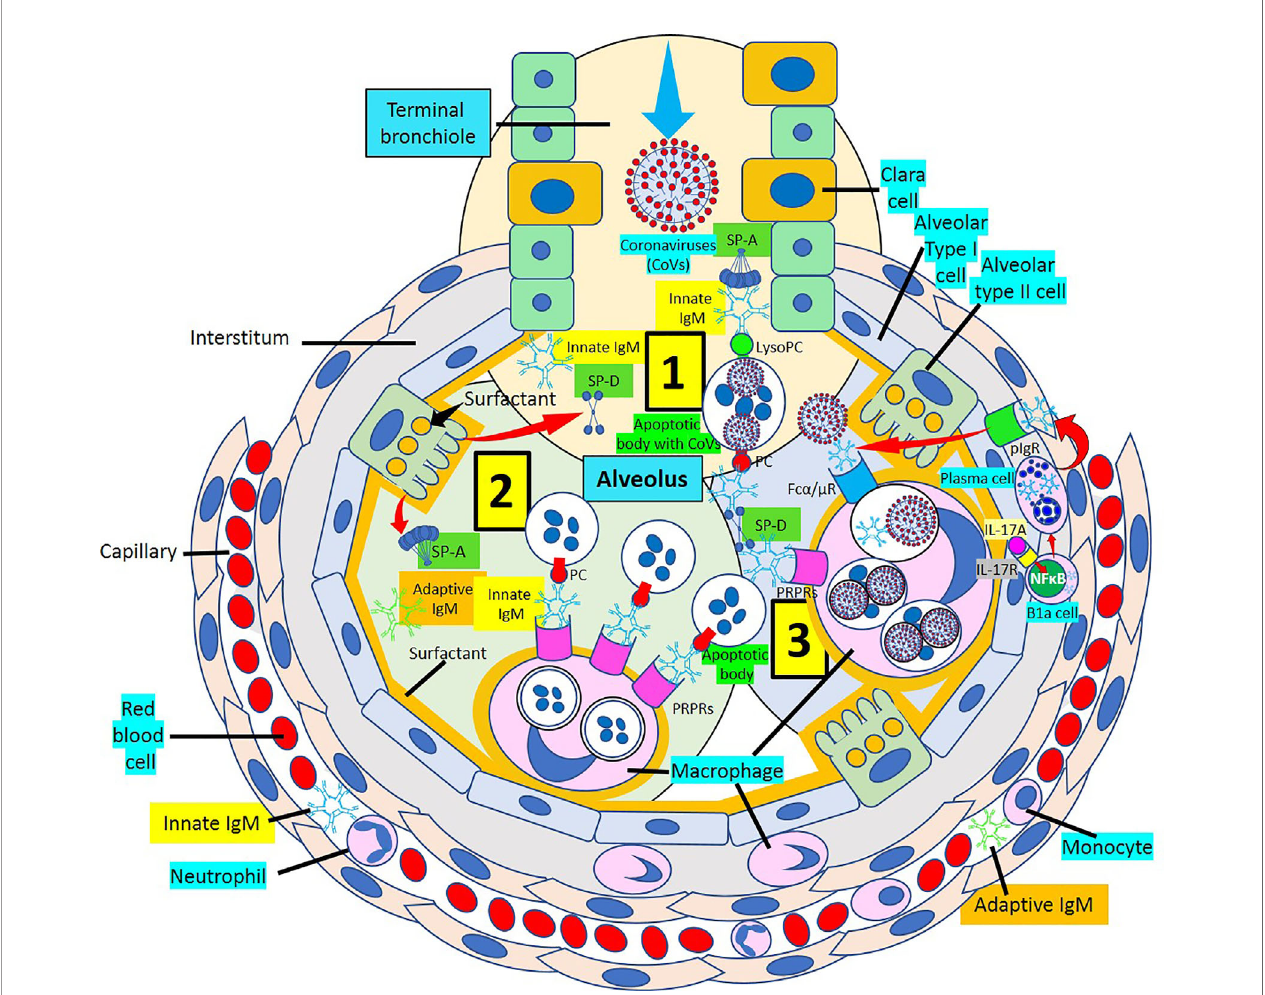
FIGURE 10 | Alveolus showing IgM response to coronavirus infection. [1] The arrival of coronaviruses into the alveolus generates an immediate IgM response mediated by innate and adaptive IgM antibodies. The IgM response in association with surfactant proteins D and A (SP-D and SP-A) facilitate virus neutralization and virus-infected apoptotic cell removal. [2] Innate and adaptive IgM participate in the macrophage-mediated removal of alveolar apoptotic cells through pattern recognition protein receptors (PRPRs) avoiding in fl ammation. [3] Virus-infected apoptotic cells are phagocytosed with the help of SP-D and SP-A through PRPRs. Recruitment of B1a cells into the alveolar wall under the stimulation of interleukin (IL)-17A via IL-17 receptor (IL-17R) and nuclear factor (NF) k B activation generate plasma cells that release IgM into the wall that is transported to the alveolus via polymeric immunoglobulin receptors (pIgRs). Viral particles bind IgM and are phagocytosed via Fc a / m receptors (Fc a / m Rs). lysoPC,